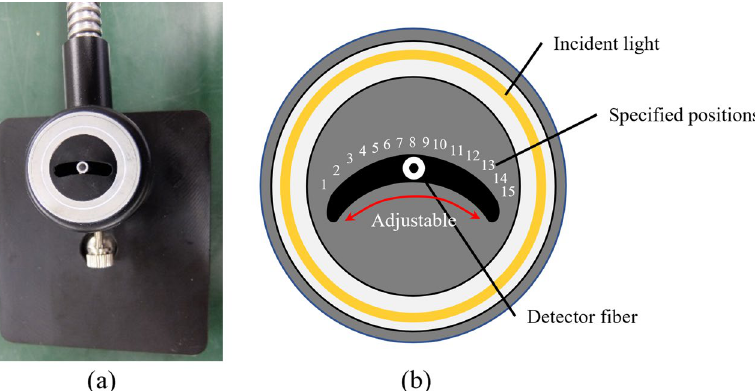
Figure 11. Ring illuminator and detector ( a ) and its schematic diagram ( b ) used to acquire interactance measurements. The ring-type design of the illuminator enhances the intensities of incident light and interactance collected by the detector. The detector is movable between preset positions from number 1 to 15, and the distance between any two adjacent positions is constant (2 mm). The illustration in the schematic diagram ( b ) was made using Microsoft PowerPoint for Microsoft 365 (https:// www. micro soft. com/ ja- jp/ micro soft- 365/ power